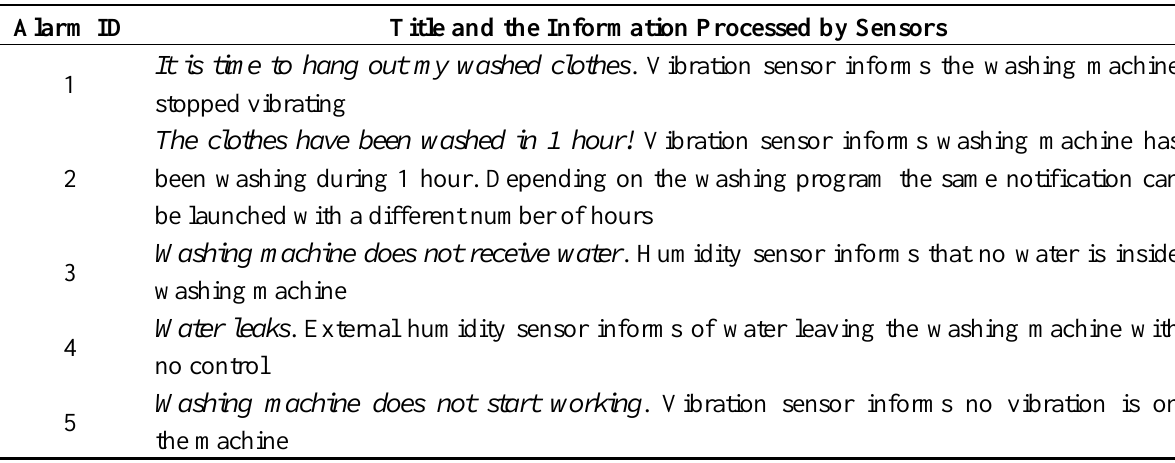
Table 3. Notifications of the washer